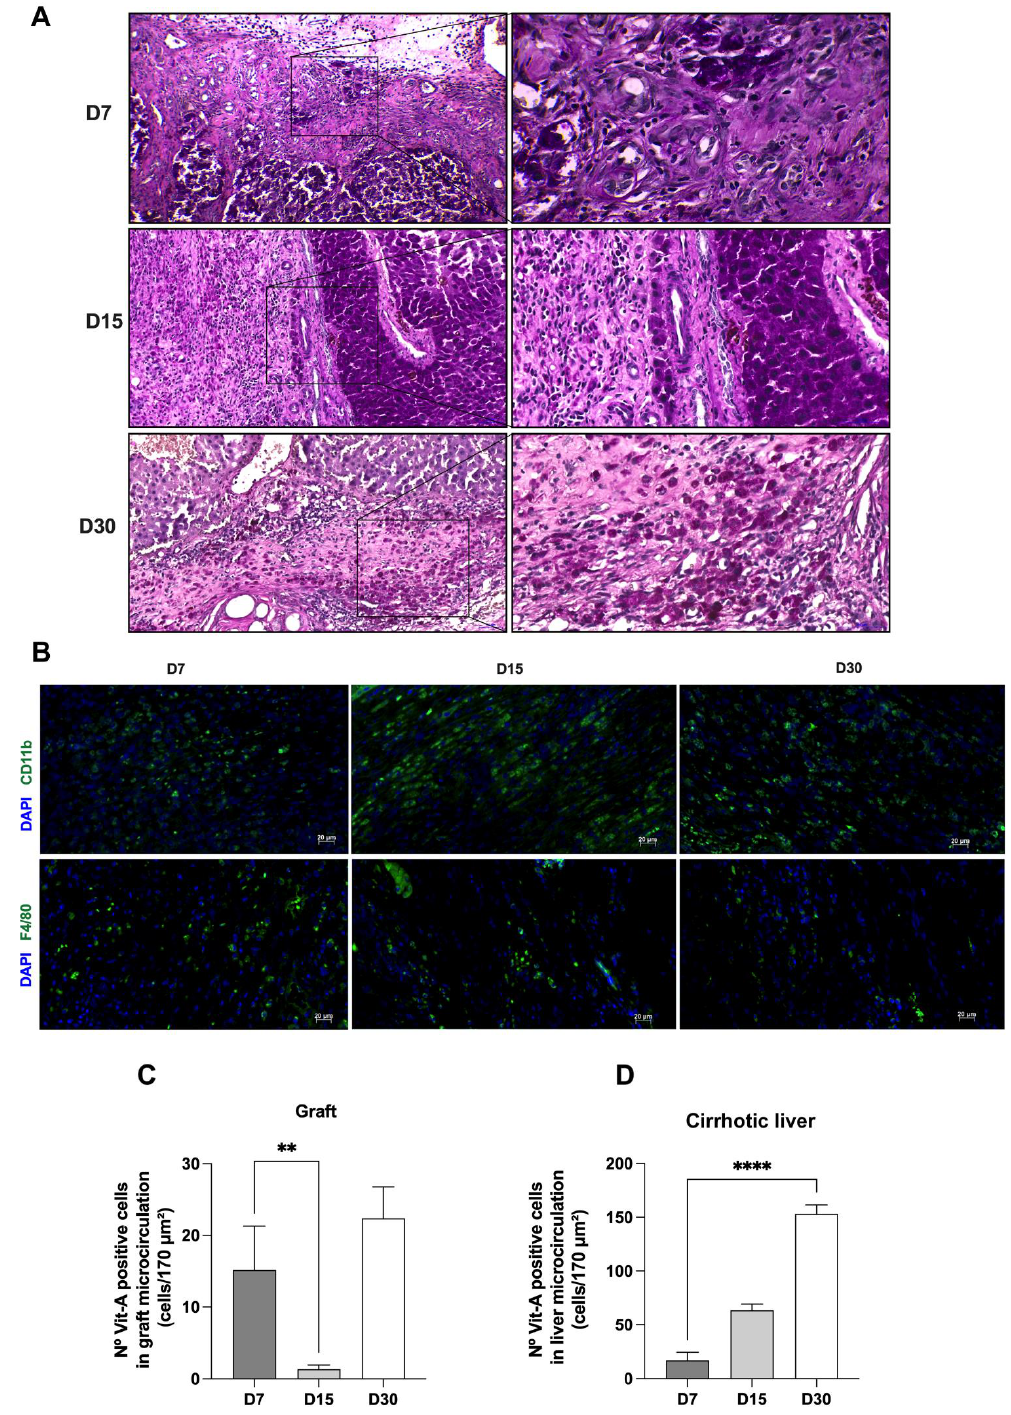
Figure 8. ALS can be recellularized by parenchymal and non-parenchymal liver cells after trans- plantation in cirrhotic rats. Histological sections stained with periodic acid–Schiff (PAS) stain showed glycogen-positive cells at all analyzed time points ( A ). Scale bars: 50 µ m. Immunofluo- rescence analysis confirmed the presence of CD11b- and F4/80-positive cells in the scaffold 7, 15, and 30 days post-transplantation ( B ). Scale bars: 20 µ m. Number of vitamin A-positive cells in the graft ( C ) and liver ( D ) microcirculation at 7, 15, and 30 days post-transplantation (significant differences were assessed by applying Student’s t -test; D7, n = 6; D15, n = 3; D30, n = 5, ** p < 0.05, **** p <